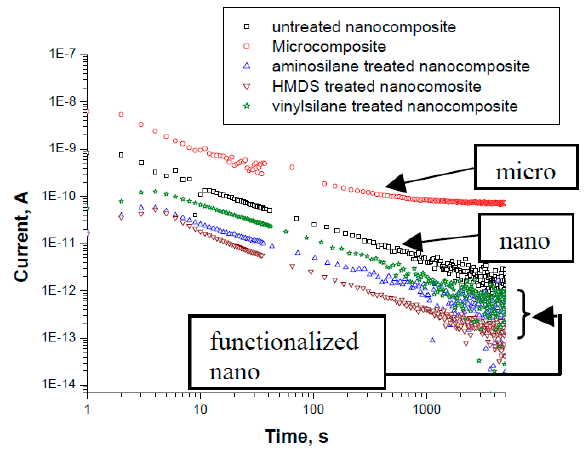
Figure 23. Absorption current dependent on time for XLPE/SiO 2 micro/nanocomposites (© 2016 IEEE. Reprinted, with permission, from [102]).